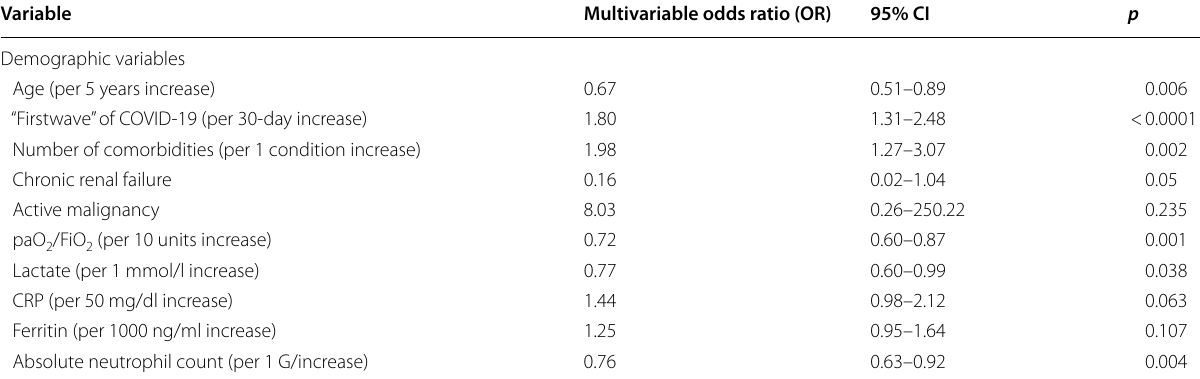
Table 2 Propensity score model for treatment group assignment